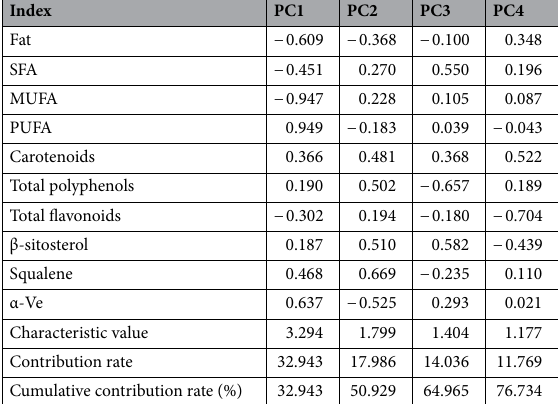
Table 4. Component load matrix of each nutritional